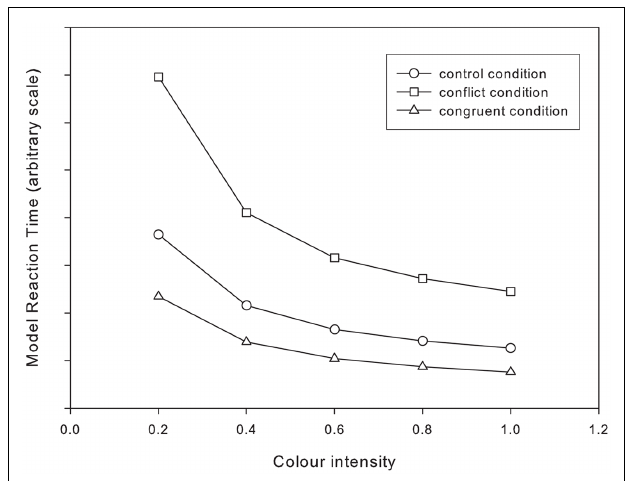
FIGURE 7 | Simulation data for two stage model with unlocked inputs.